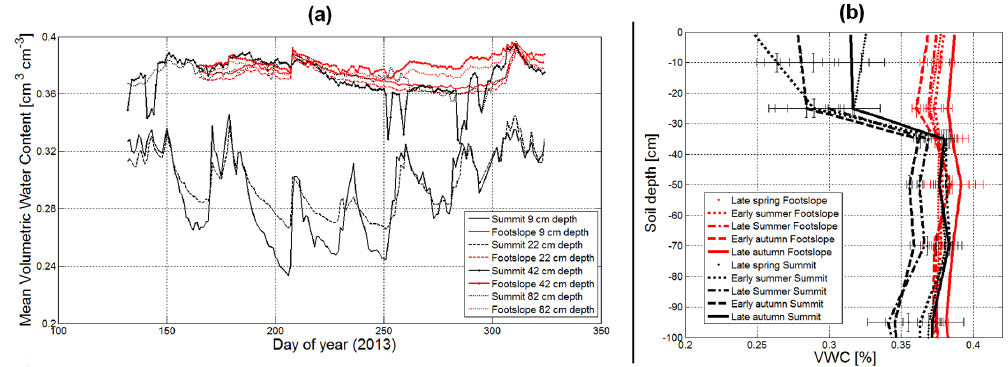
Figure 7. Space-time dynamic of soil moisture at the summit (red) and the footslope (black) position in 2013: (a) time series at different depths; (b) profile at different